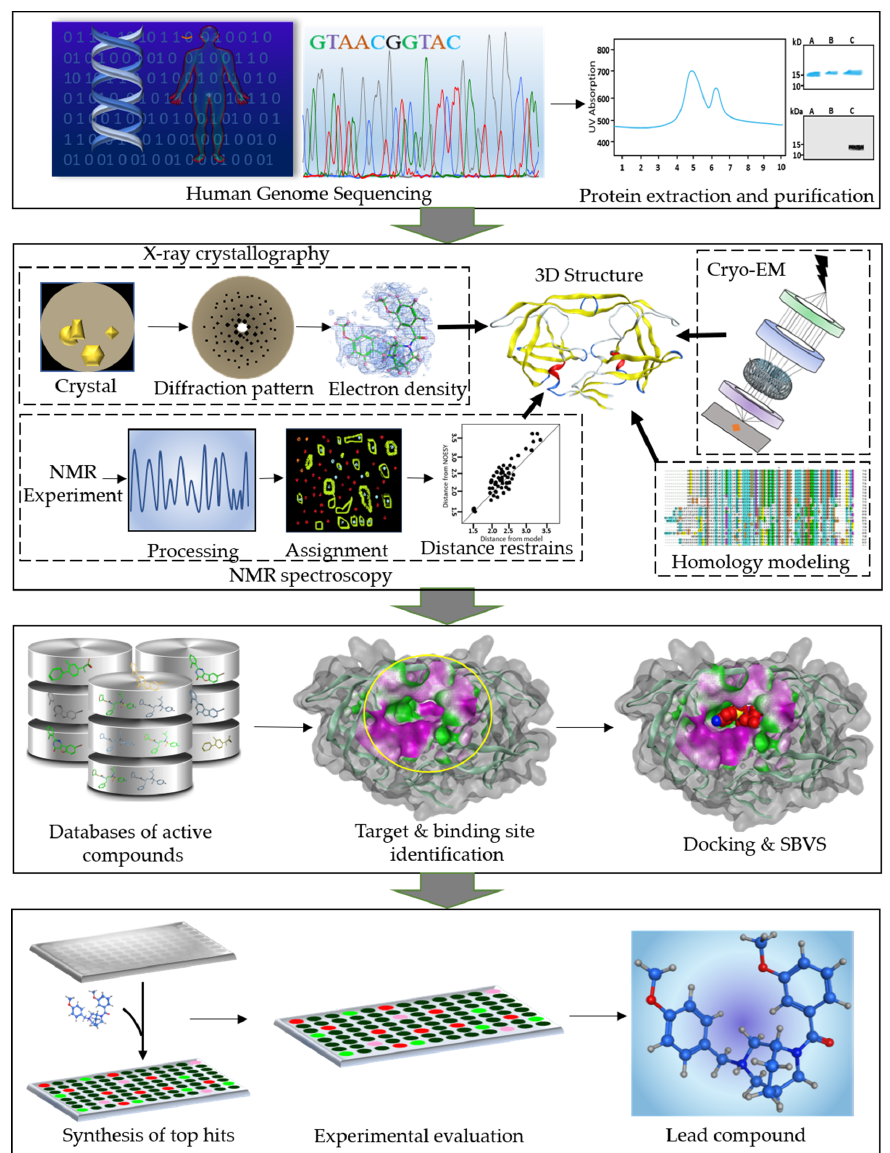
Figure 1. A workflow diagram of structure-based drug design (SBDD) process. The first panel shows the human genome sequencing followed by extraction and purification of the target